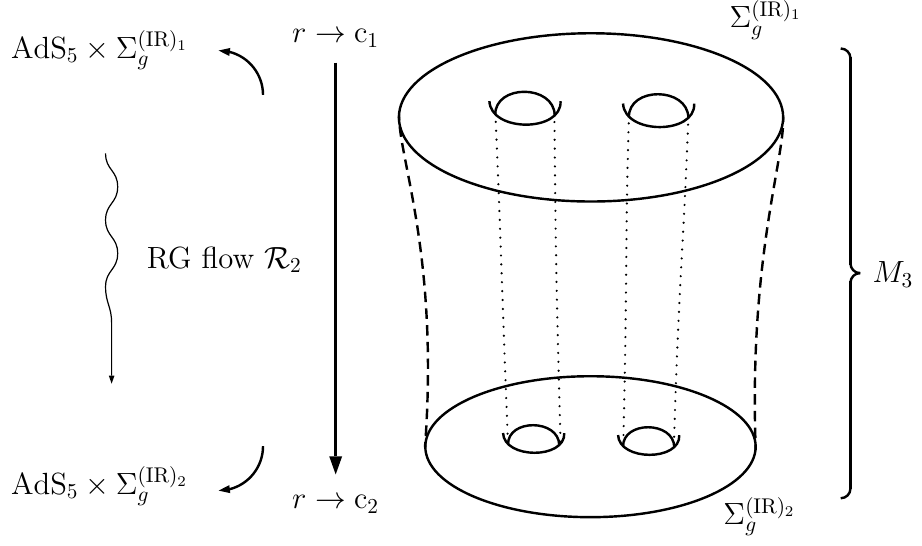
Figure 2 . A very schematic sketch of the holographic renormalization group (cid:13)ow di(cid:11)erent AdS 5 (cid:6) (IR) i g (cid:12)xed points. This case relates two infrared theories and thus the Riemann (cid:2) surfaces (cid:6) (IR) i g are already uniform.